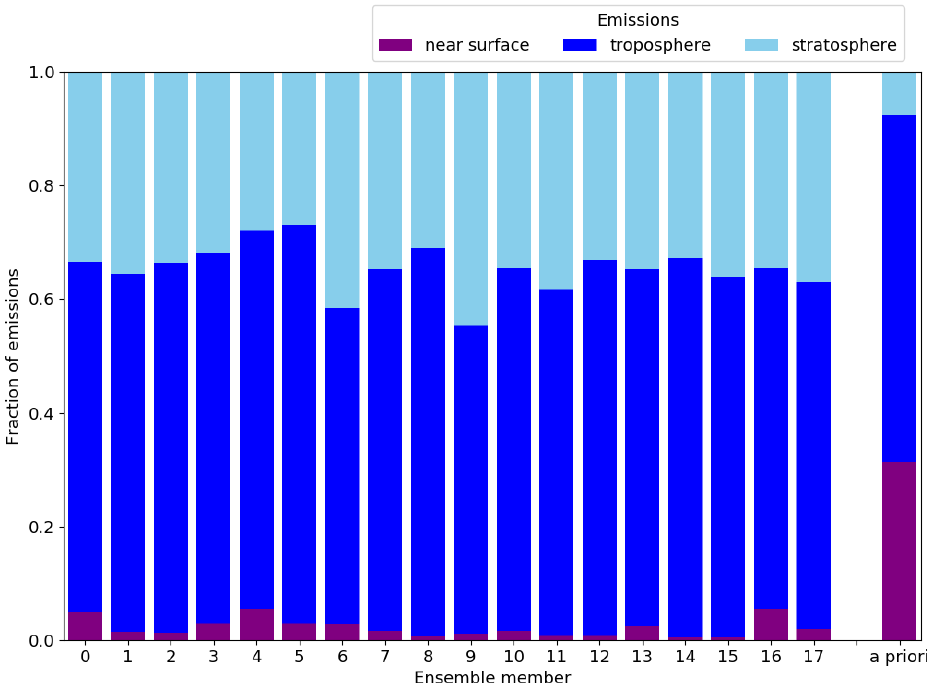
Figure 5. The fraction of total ash during the 2019 Raikoke eruption emitted near the surface (0–4km), in the troposphere (4–12km) and in the stratosphere (above 12km) for each member in the MOGREPS-G ensemble determined using InTEM. The final bar shows the fraction of ash emitted near the surface, tropopause and stratosphere in the prior emission